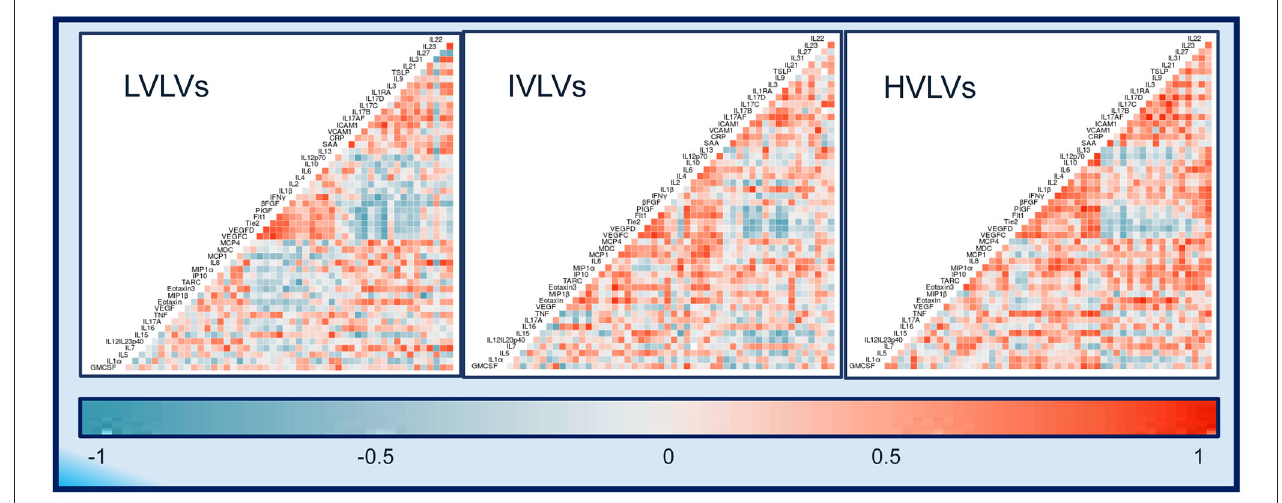
FIGURE 5 | Correlograms of the correlations between 52 plasma protein concentrations for Low viral load volunteers (LVLVs), Intermediate viral load volunteers (IVLVs) and High viral load volunteers (HVLVs). Blue and red squares represent positive and negative correlations, respectively with darker colours indicating a greater magnitude of